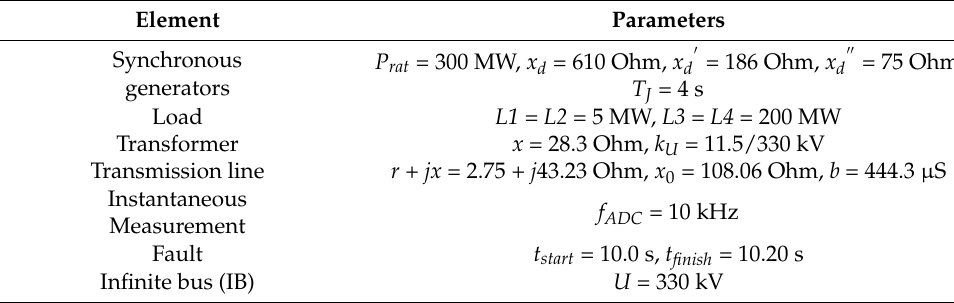
Table 2. Parameters of the two ‐ machine power system model.